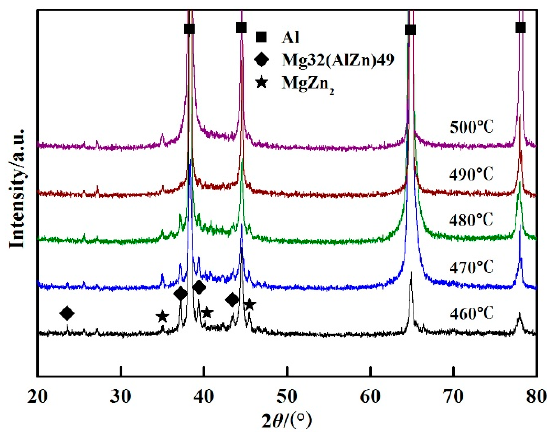
Figure 4. XRD patterns of the welded joints after PWHT with solution at different temperatures for 60 min followed by aging at 120 °C for 24 h.